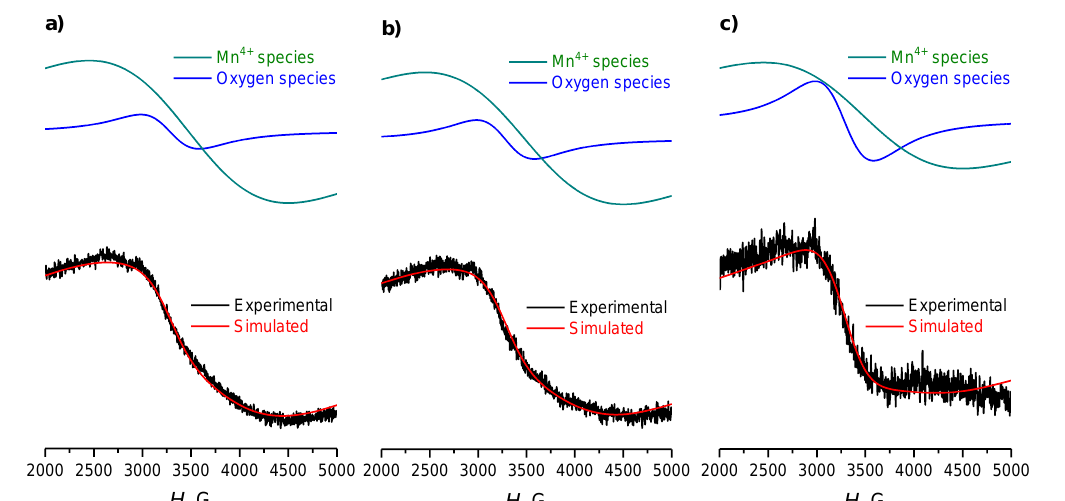
Figure 7. Experimental and simulated EPR spectra of Mn-Zr catalysts, calcined at ( a ) 500 °C, ( b ) 600 °C and ( c ) 700 °C. Different components of the spectra are presented above each simulated curve.